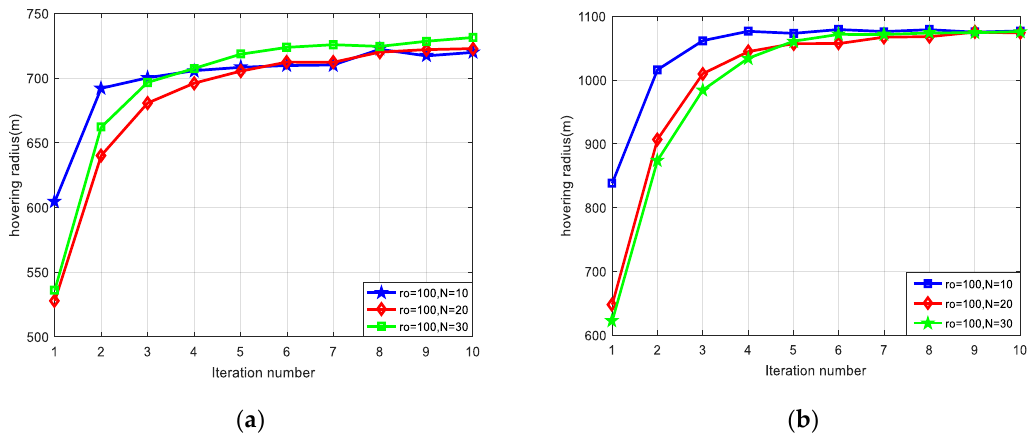
Figure 4. The iterative process of hovering radius in joint optimization. R o is 1500 m ( a ) and 2000 m ( b ).